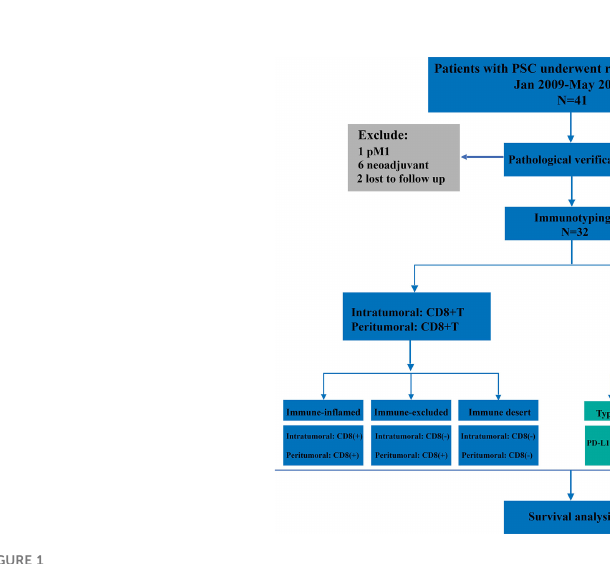
FIGURE 1 A fl ow chart of the research